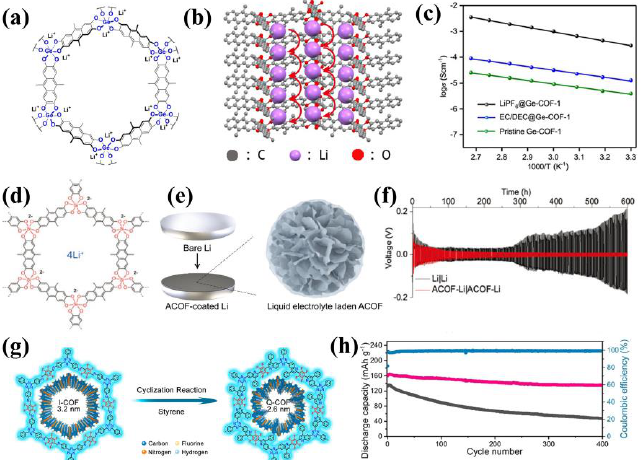
Figure 12. ( a ) Structure of germanate covalent organic framework Ge − COF − 1; ( b ) Side view of the channel and potential Li − ion hopping pathway along the channel; ( c ) Arrhenius plots of different Ge − COF. Reproduced with permission from Ref. [68], Copyright (2019), John Wiley and Sons; ( d ) Schematic illustration shows ACOF − coated Li, where the ACOF is composed by particles of 2D nanosheets that are laden with liquid electrolyte; ( e ) Structural representation of ACOF; ( f ) Galvanostatic cycling of Li symmetric cells at 1 mAh cm −2 and 1 mA cm −2 . Reproduced with permission from Ref. [69], Copyright (2021), John Wiley and Sons; ( g ) Synthesis of Q − COF by the cyclization reaction of I − COF; ( h ) Cycling performance of Li|Q − COF|NMC811 cells with Q − COF prepared at high temperature (pink) and RT (black). Reproduced with permission from Ref. [66], Copyright (2021), John Wiley and Sons.